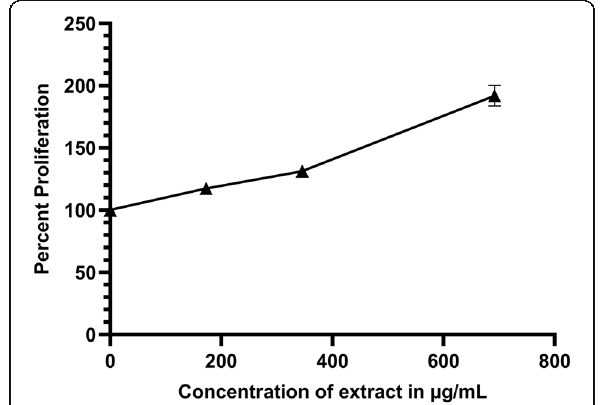
Fig. 2 The effect of AELE on MNCs isolated from Human Bone Marrow. AELE showed no inhibitory effect on Mononuclear Cells (MNCs) isolated from Human Bone